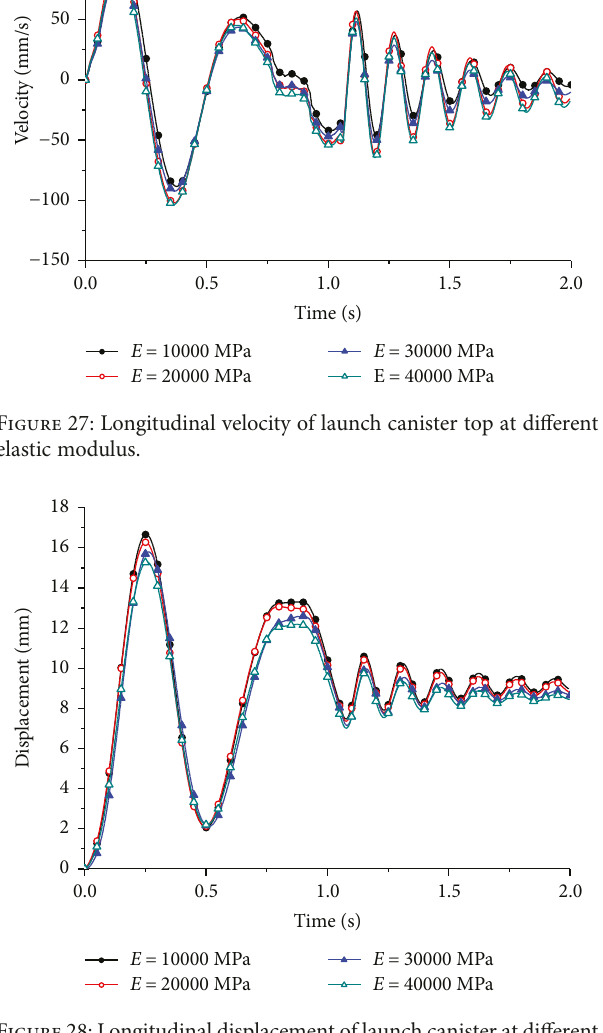
Figure 28: Longitudinal displacement of launch canister at di ff erent elastic